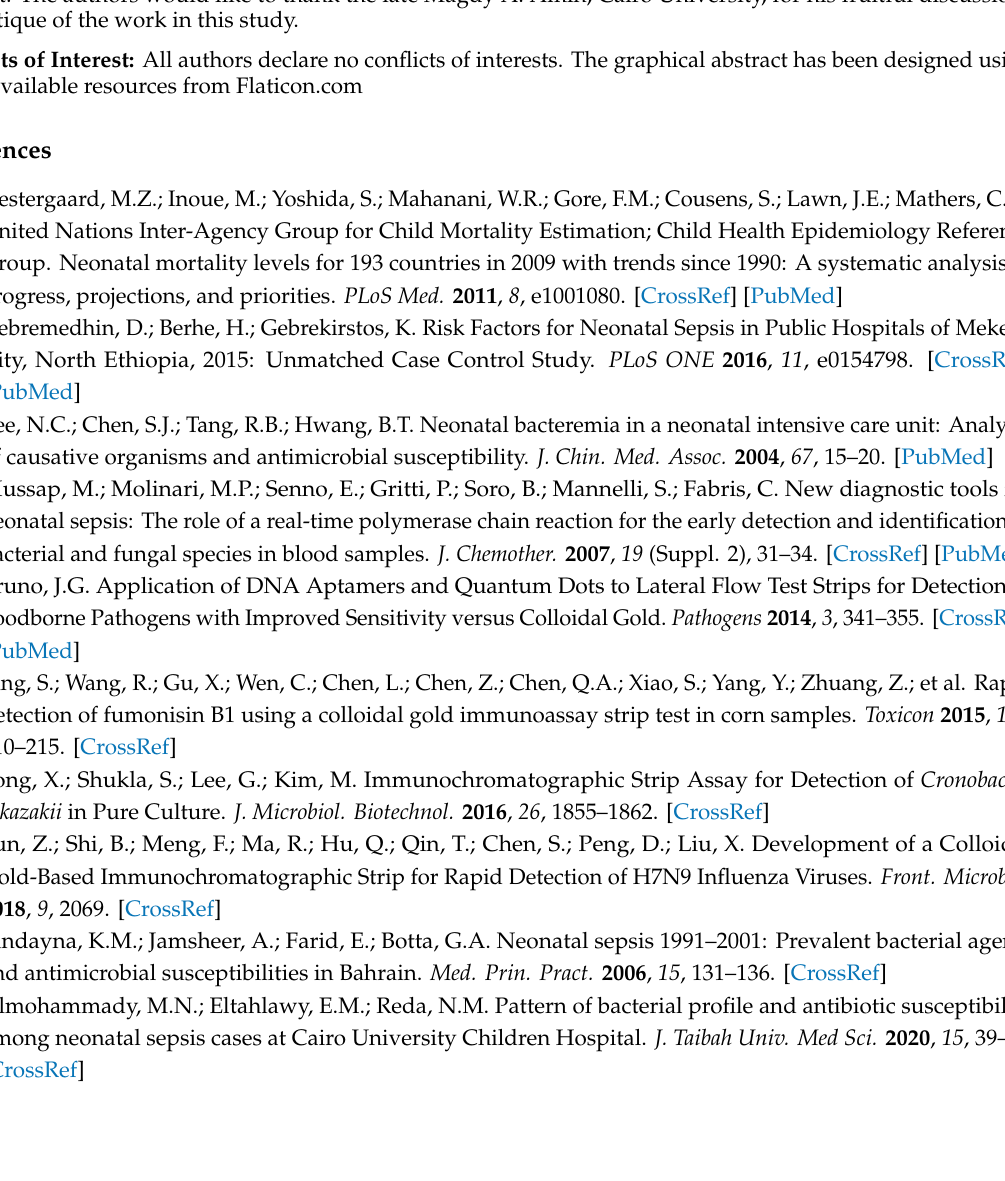
Figure S1: Phylogenic tree of the blast data in tree representation showing target peptide relationship to its nearest blast hits. Figure S2: Confirmation of the NWMN_1649-6xHis fusion protein construct. Table S1: Results of BLAST analysis of the DNA sequence encoding the target peptide with results of the strains belonging to di ff erent STs known to be involved in neonatal infections